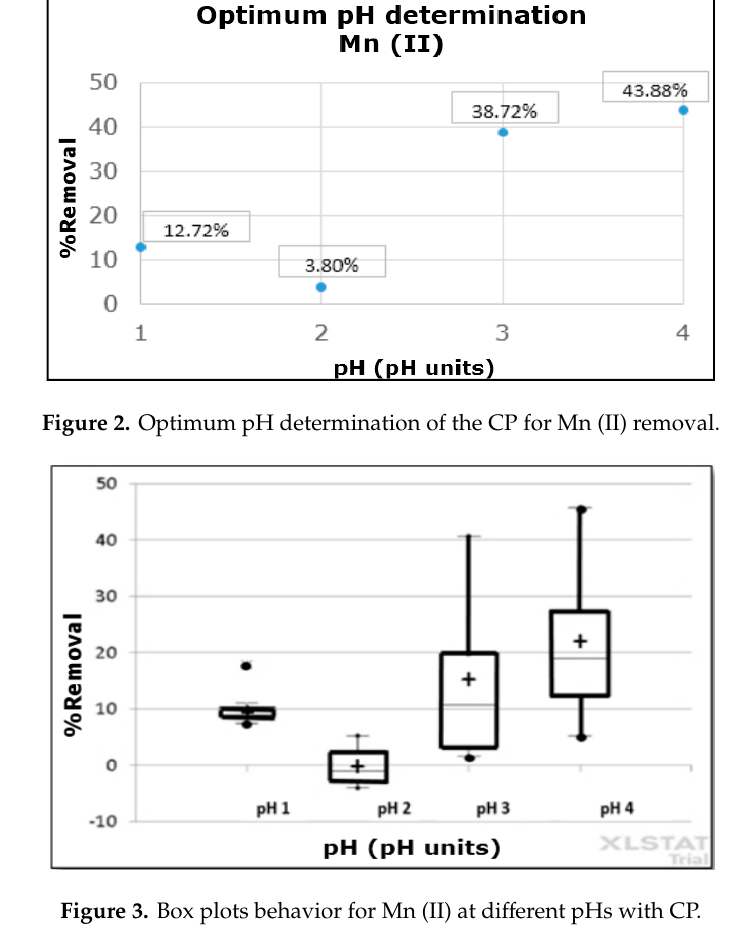
Figure 3. Box plots behavior for Mn (II) at different pHs with CP.